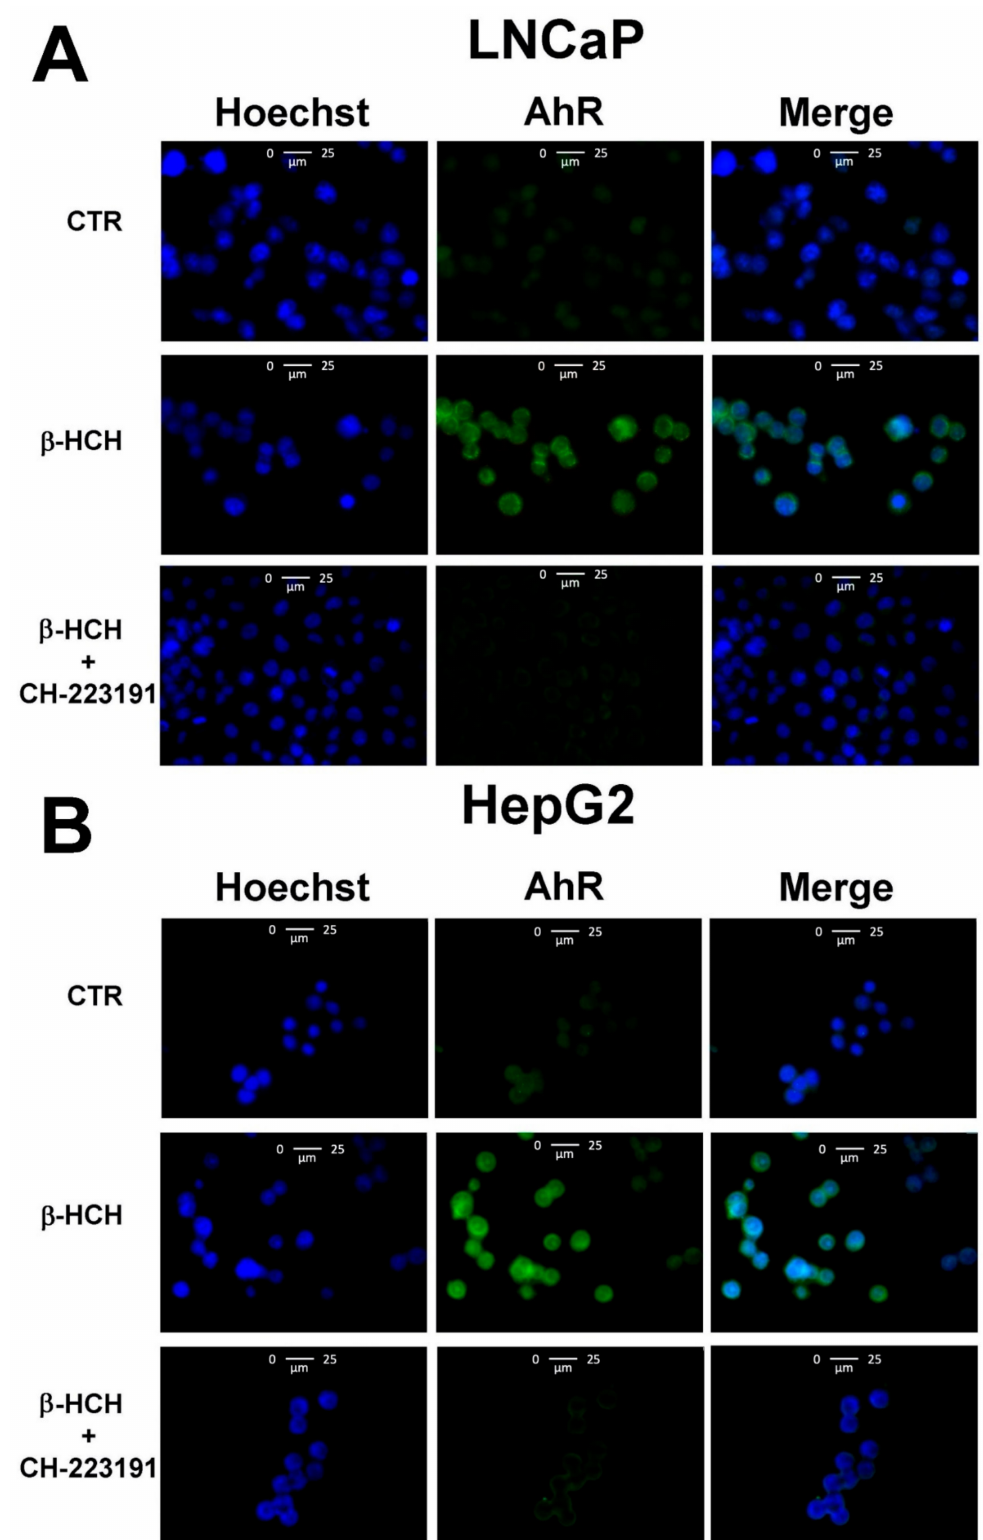
Figure 6. Cellular distribution of AhR followed by immunofluorescence in LNCaP ( A ) and HepG2 ( B ) cells. CTR: Control untreated cells; β -HCH: Cells after 4 h of 10 µ M β -HCH stimulation; β -HCH + CH223191: Cells after 2 h pre-incubation with 150 nM CH223191 followed by 4 h of 10 µ M β -HCH